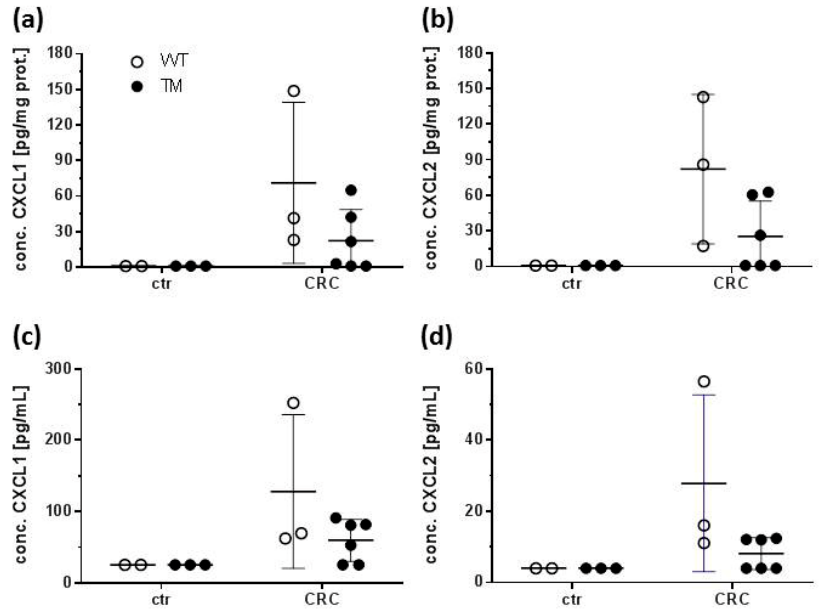
Figure 4. Colon homogenates and sera were prepared out of the mice described in Figure 1. The concentrations of CXCL1 and CXCL2 were quantified using a multiplex ELISA technique. ( a,b ) Concentrations of ( a ) CXCL1 and ( b ) CXCL2 in colon homogenates. ( c,d ) Concentrations of ( c ) CXCL1 and ( d ) CXCL2 in sera. WT: wild type, TM: H 4 R − / − , ctr: AOM-treated mice, CRC: AOM / DSS-treated mice. Individual values and means +/ − SD of n = 2–6. No significant differences (two-way ANOVA with Sidak’s post hoc test).